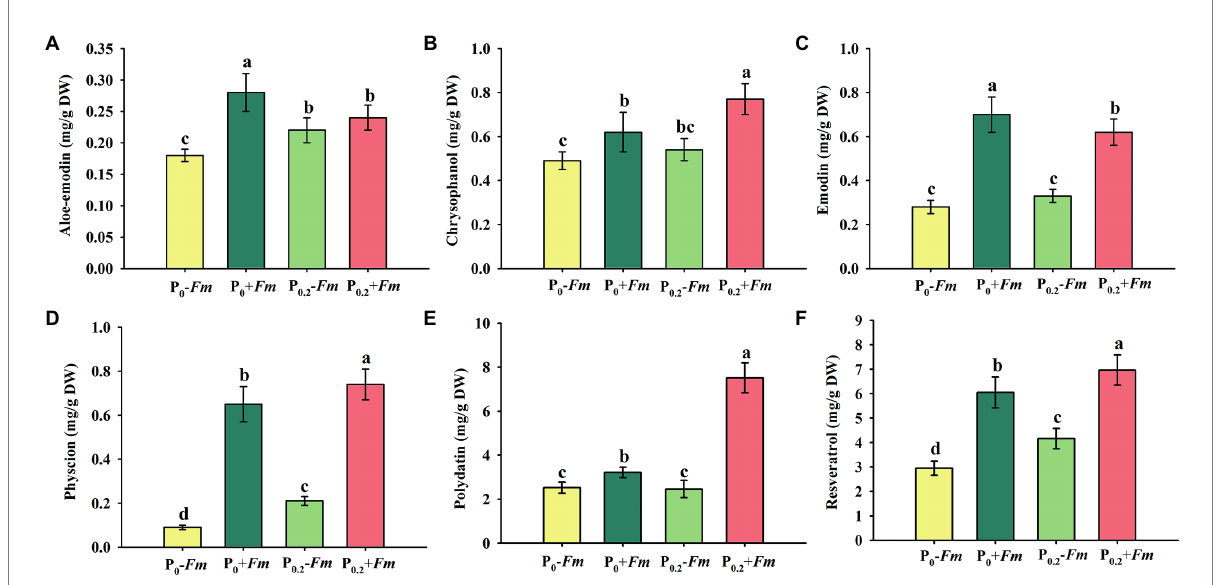
FIGURE 4 Changes in root aloe-emodin (A) , chrysophanol (B) , emodin (C) , physcion (D) , polydatin (E) , and resveratrol (F) of Polygonum cuspidatum by Funneliformis mosseae and P supply. Data (means ± SD, n = 4) followed by different letters above the bars indicate significant ( p < 0.05) differences among treatments. + Fm , inoculation with F. mosseae ; − Fm , inoculation without F . mosseae ; P 0 , 0 M P; P 0.2 , 0.2 M P; P, phosphorus.